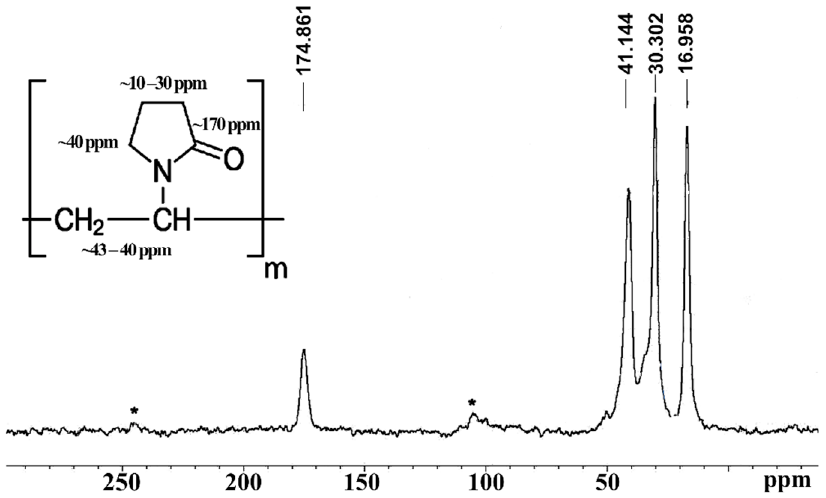
Figure 3. The NMR spectrum of MAS 13 C{ 1 H} for the PVP polymer. N - Р olyvinylpyrrolidone structure (insert). *—satellites from the rotation of the sample at a frequency of 7 kHz (sample 3).